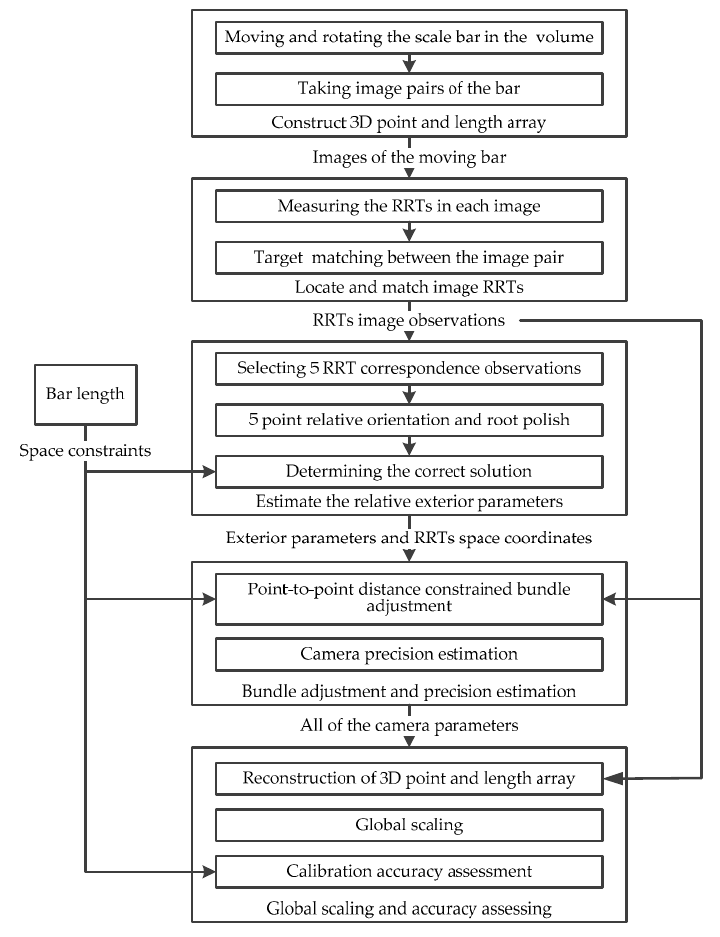
Figure 1. Key components and procedures of the method.